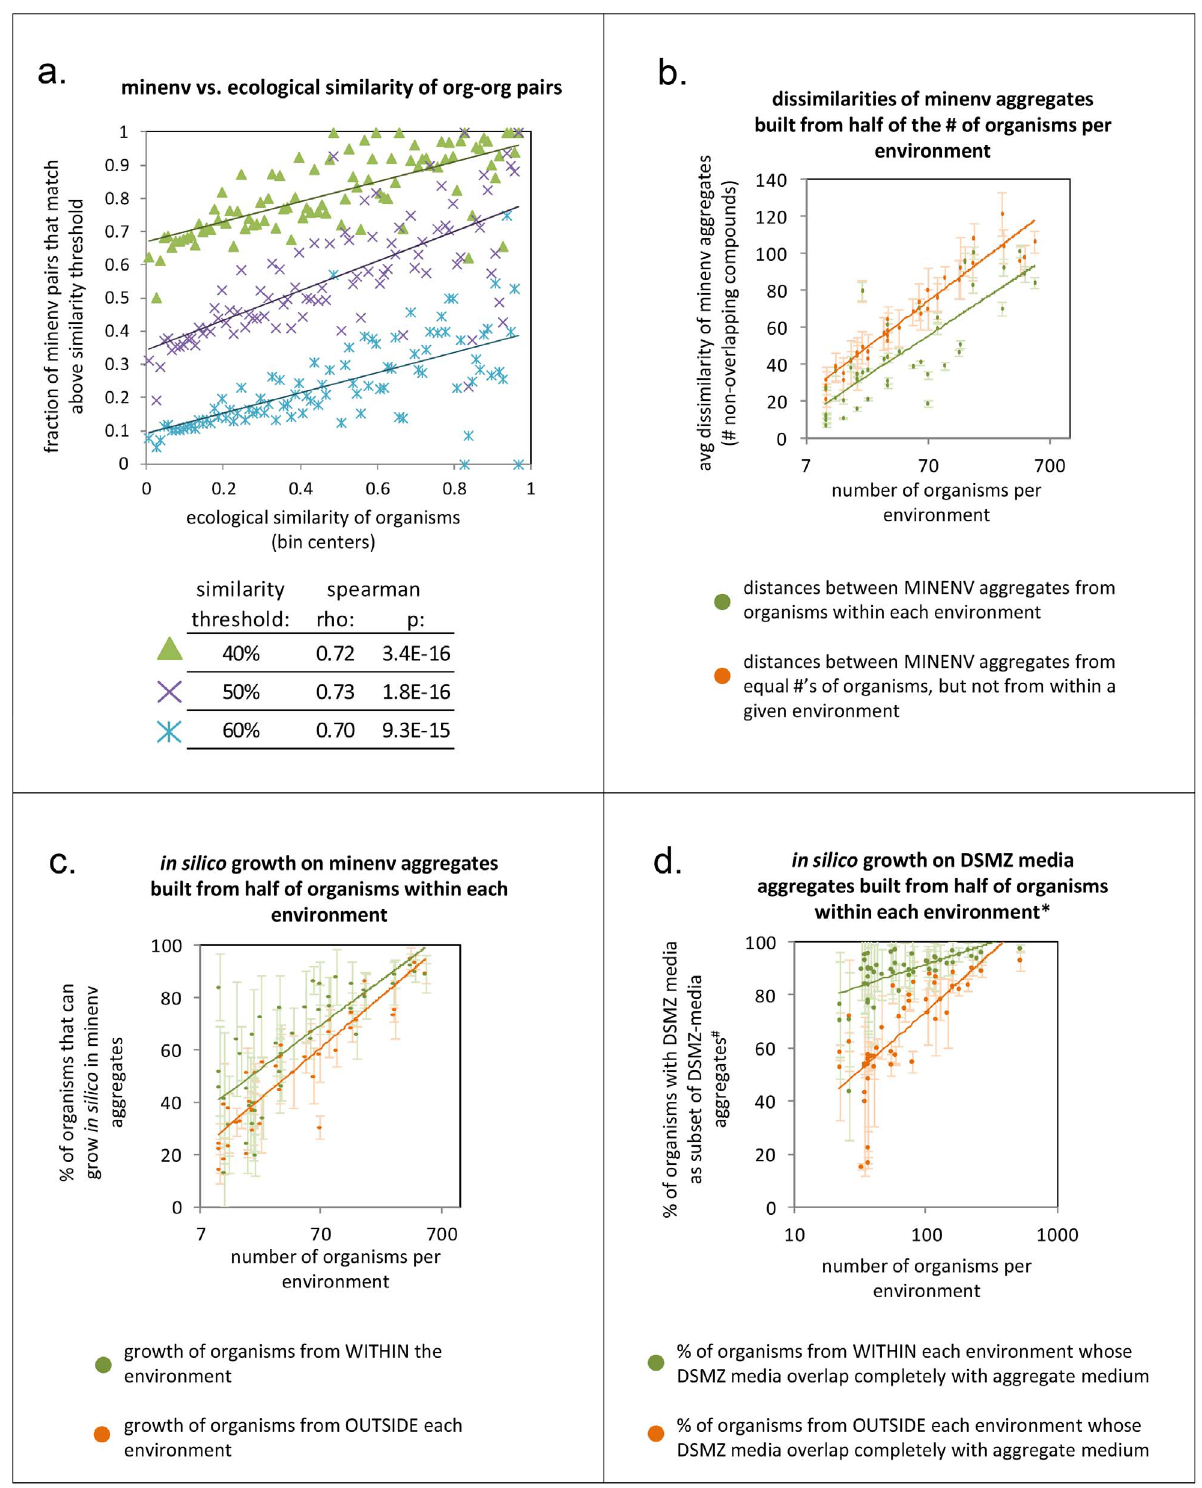
Figure 2. Nutritional requirements are more similar among ecologically co-distributed organisms. (A) Similarity of ecological distributions (in Greengenes) and also similarity of MINENVs were calculated for each of , 3 million organism-organism pairs, using jaccard metrics (see methods). Org-org pairs were then binned by ecological distance (x-axis), and the ratio of pairs in each bin with a MINENV similarity above some percentage threshold (i.e., 100*jaccard similarity) was determined (y-axis). A range of MINENV similarity thresholds were explored; three are shown on the plot, along with the correlation coefficients between ecological and MINENV similarities. Each dot on the plot represents all org-org pairs falling into a given ecological distance bin. (B) microorganisms from within each Greengenes environment are split into two groups 100 times, and distances between aggregate minenvs for each group are compared (each green dot is an environment; see methods). This was repeated each time for the